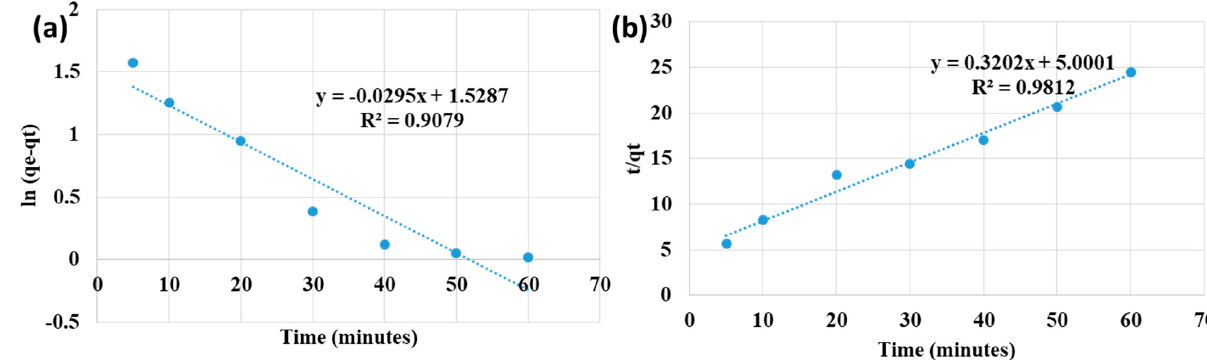
8 of 15 Figure 7. Percent adsorption of RBV-5R dye using sugarcane Bagasse biosorbent for synthetic and industrial dye samples. 3.8. Kinetic Study of the Adsorption of RBV-5R by SCB The order of the adsorption of RBV-5R dye by SCB was identified by implementing the pseudo-first-order (PFO) and the pseudo-second-order (PSO) kinetic models (Equa- tions (4) and (5)), respectively, and the respective kinetic parameters were determined (Figure 8, Table 1). (5) The time course data fits the pseudo-second-order kinetic model because, in com-